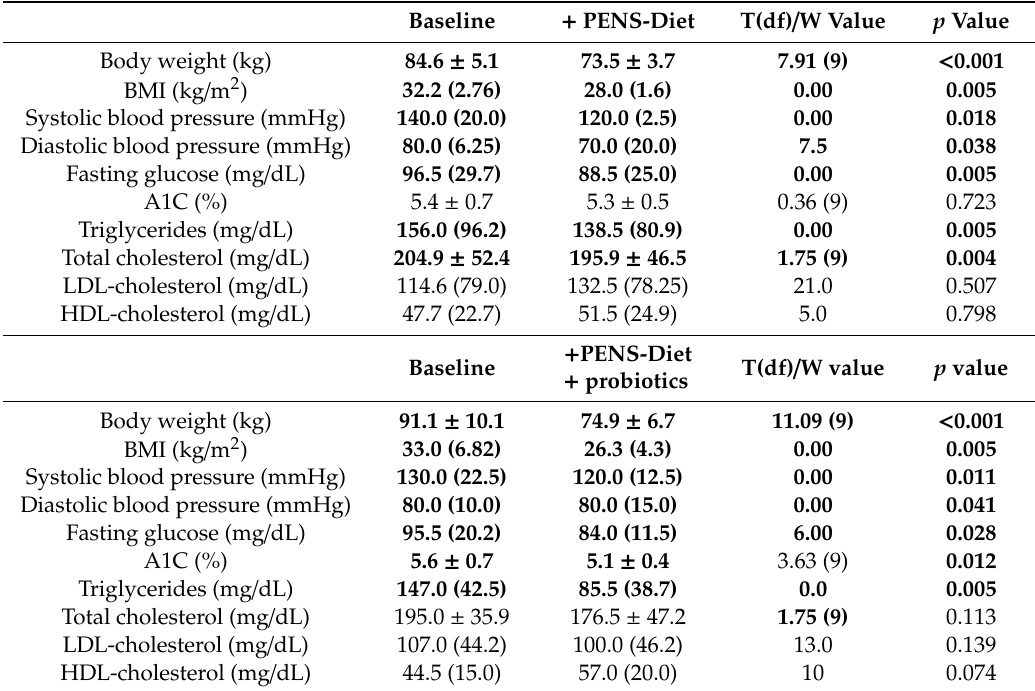
Table 3. Weight loss and improvement of blood pressure, glycemia, and dyslipidemia after PENS-Diet or PENS-Diet + probiotics interventions.